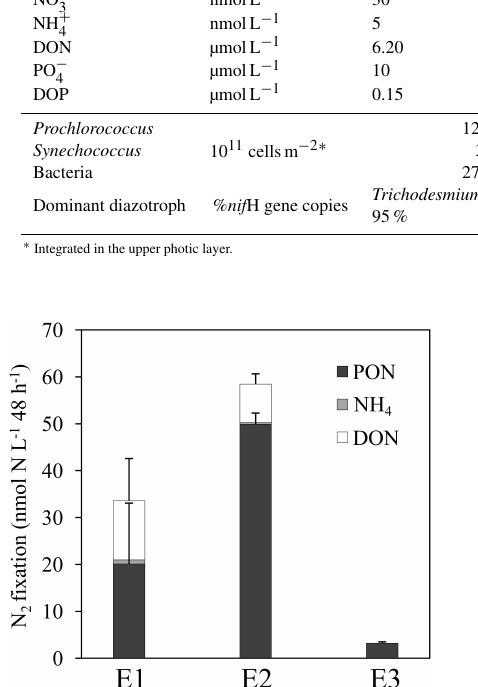
Figure 2. N 2 fixation rates (black, nmolNL − 1 48h − 1 ), DDN re- leasenmolNL − 1 (48h − 1 ) as NH + (light grey) and DON (white) 4 for each experiment (E1, E2 and E3). Error bars represent the stan- dard deviations of triplicate